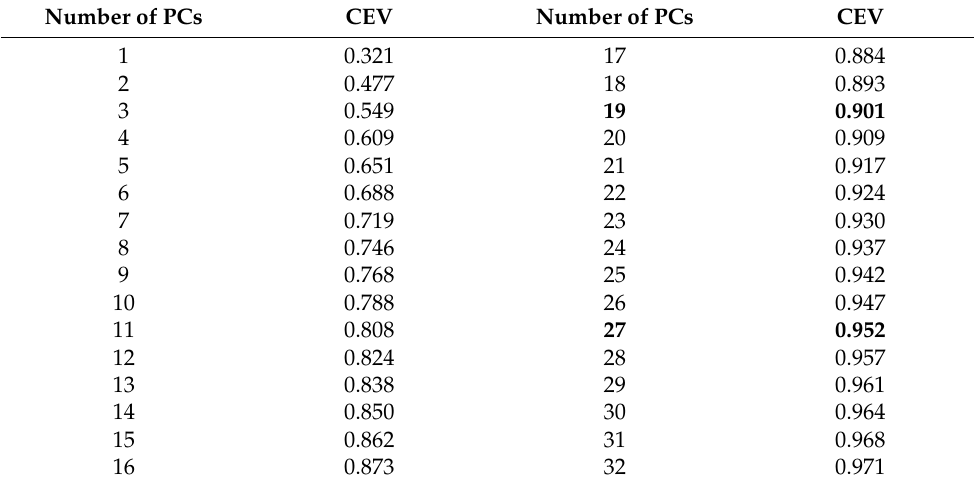
Figure 7. Cumulative explained variance by number of principal components employed. Table 4. Cumulative explained variance per number of principal components.